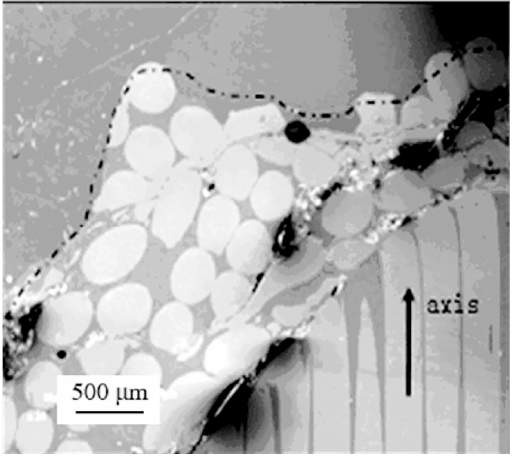
Figure 7. Metallographic photo of residual WF/Zr-MG rod at 811.2 m/s [16].